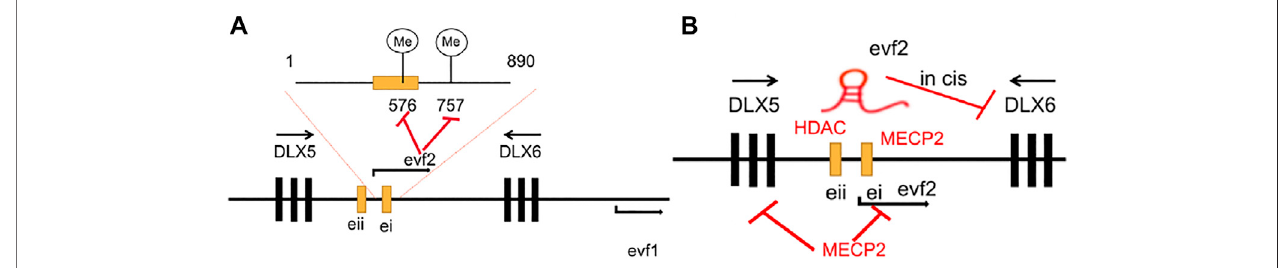
FIGURE 1 | (A) Evf2 induces 576 CpG and 757 CpG site methylation in the ultra-conserved region of DLX5/6 ei/eii. (B) Evf2 recruits MECP2 and further absorbs HDAC1 into the DLX5/6 ei/eii region to repress DLX5 and DLX6 gene